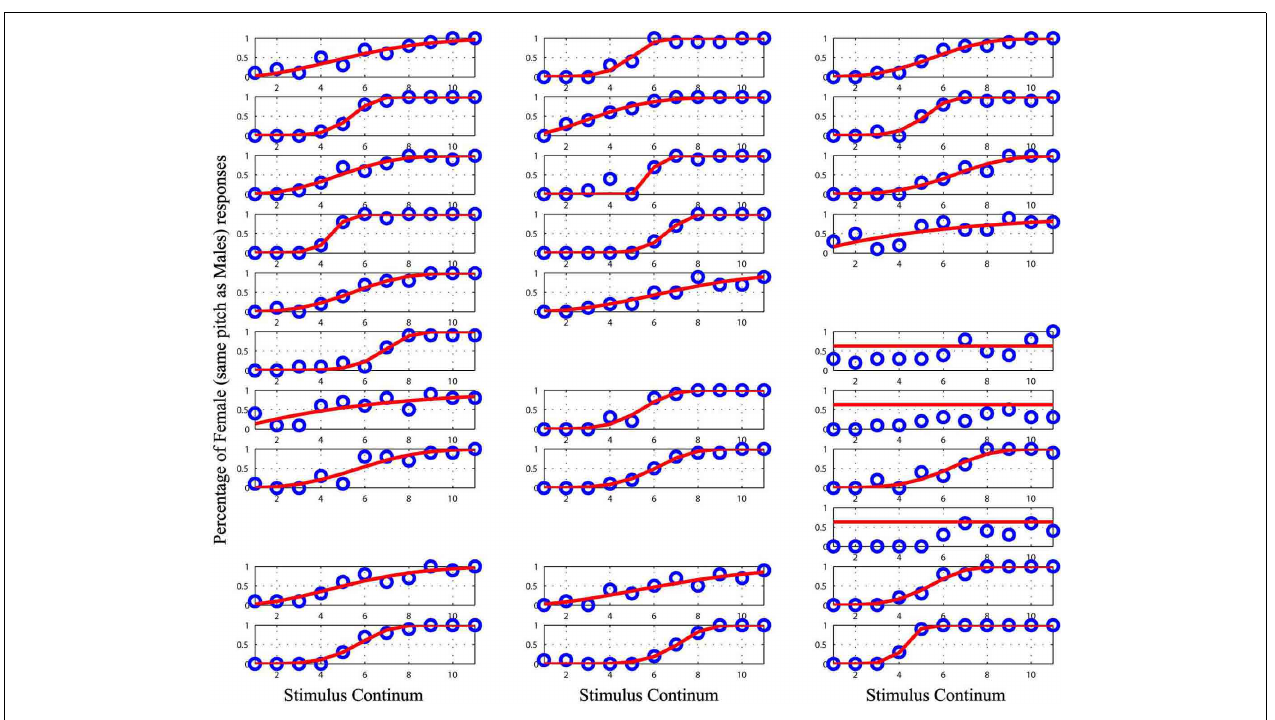
FIGURE 4 | Plot of the raw data (blue circles) and the cumulativeWeibull function (red lines) for each subject in the male/female condition with equalized pitch. Empty spaces mark missing data for subject 15, 17, 25, and 26. Data from the subject 18, 21, and 27 were removed from the analyses as they could not be modeled.